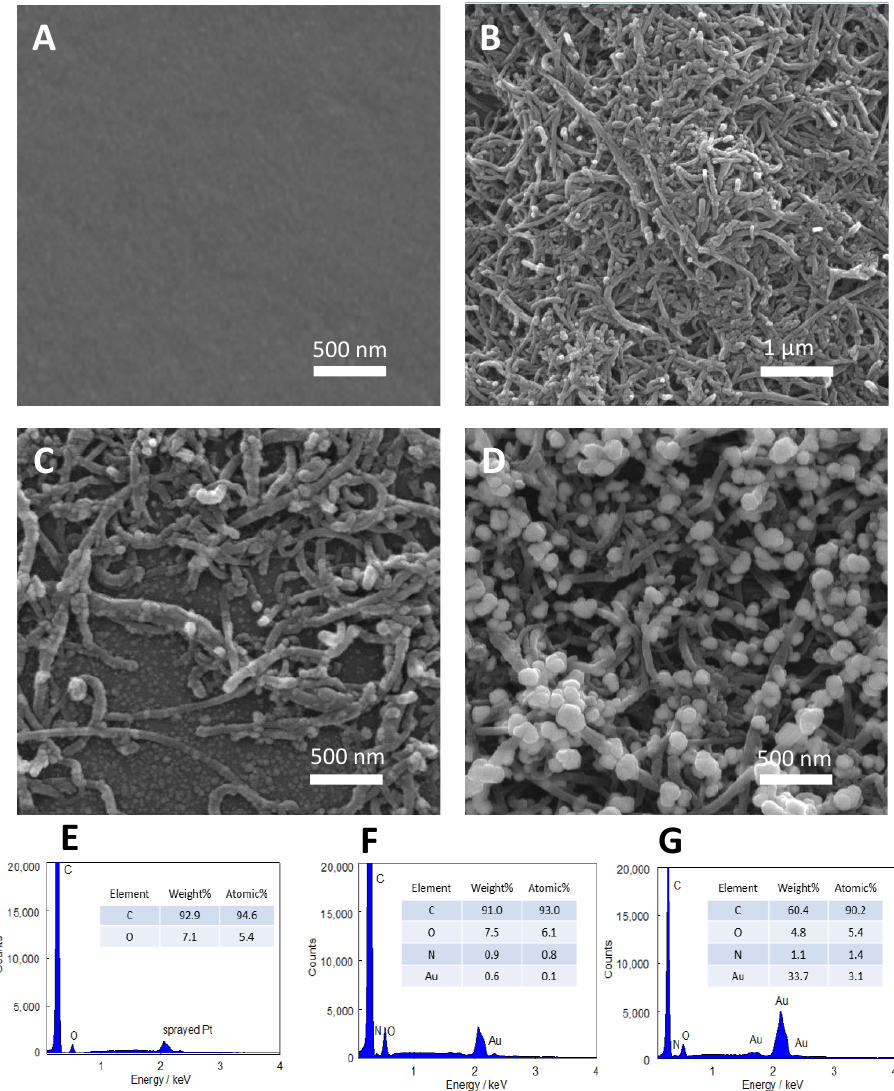
Figure 4. SEM images and EDX spectra of Py/GCE ( A , E ), Py/C-MWCNTs/GCE ( B ), AuNPs/Py/C- MWCNTs/GCE ( C , F ), and Au s /Py/C-MWCNTs/GCE ( D , G ).